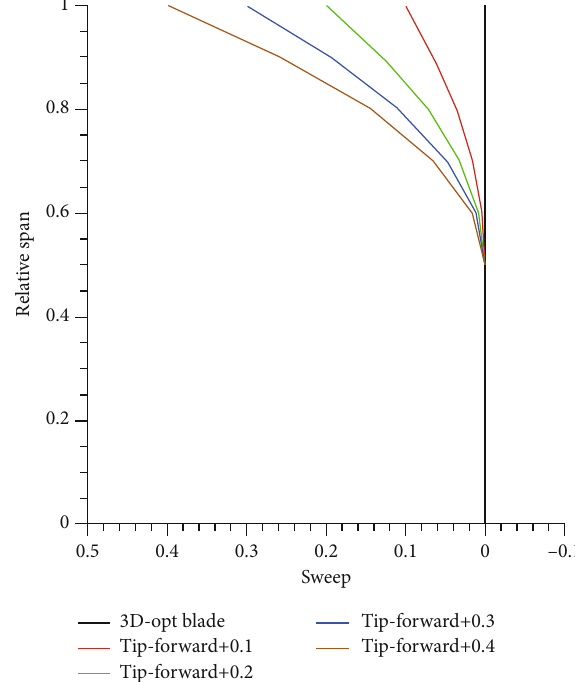
Figure 18: Stacking lines of rotor blades.